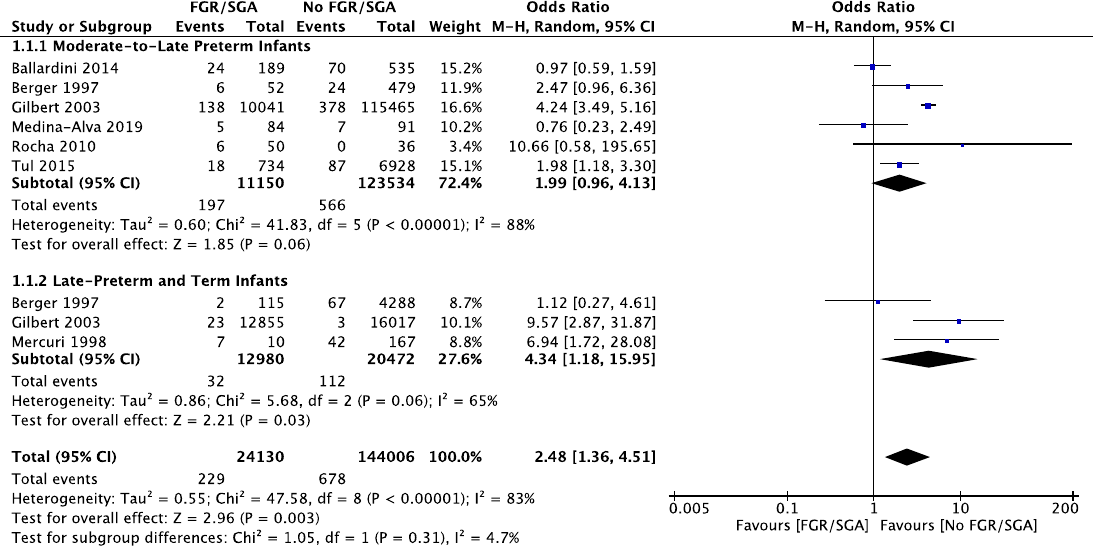
Figure 3. Forest plot comparing the risk of any cranial ultrasound abnormality among moderate to late preterm and late preterm to term subgroups with or without fetal growth restriction.